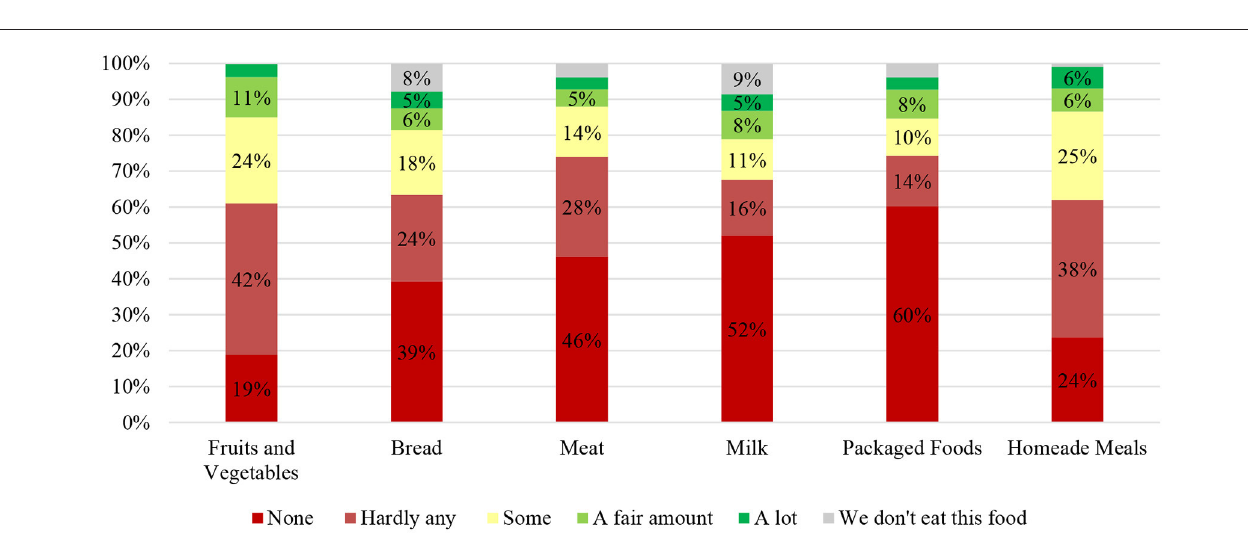
even less thinking that 10% of food is wasted (9%).